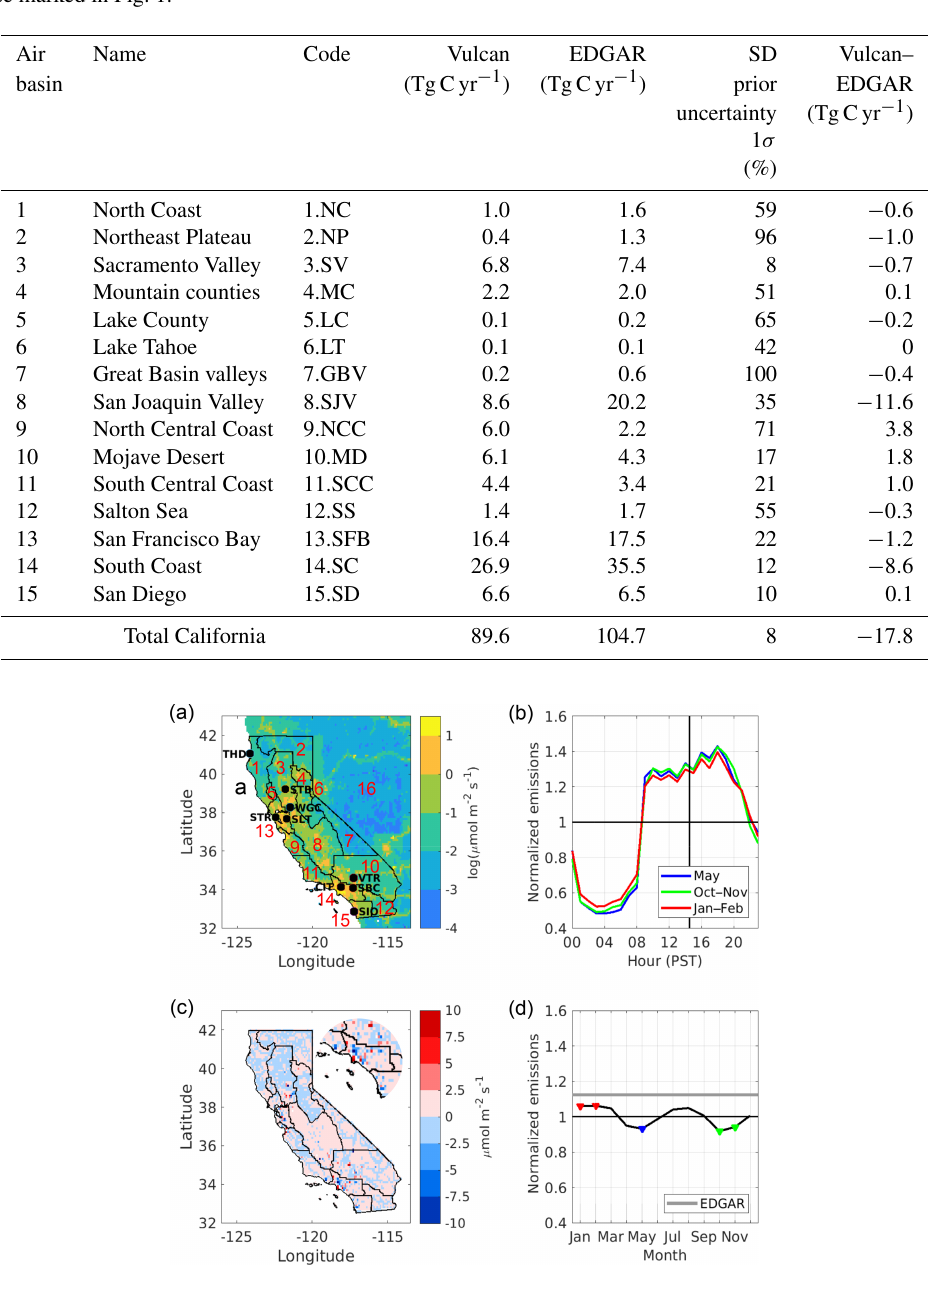
Figure 1. (a) The location of the nine tower sites in the observation network (marked with black circles): Trinidad Head (THD), Sutter Buttes (STB), Walnut Grove (WGC), Sutro Tower (STR), Sandia – Livermore (LVR), Victorville (VTR), San Bernardino (SBC), Cal- tech (CIT), and Scripps Institute of Oceanography (SIO). The 15 air basins are marked with black lines, with region 16 representing emis- sions from outside California within the model domain. Underlaid is a map of annual mean ffCO 2 emissions from the Vulcan v2.2 emission map within the United States and EDGAR v4.2 (FT2010) for emission from outside the US. (b) Vulcan diurnal emissions normalized to campaign-averaged emissions for the three campaigns; (c) scaled EDGAR emissions subtracted from Vulcan emissions map, where EDGAR has been scaled to have the same air basin total emissions. The inset shows an enlarged view of southwestern California. (d) Average monthly emissions normalized to Vulcan annual emissions. Shown in both (b) and (d) are EDGAR annual invariant emissions